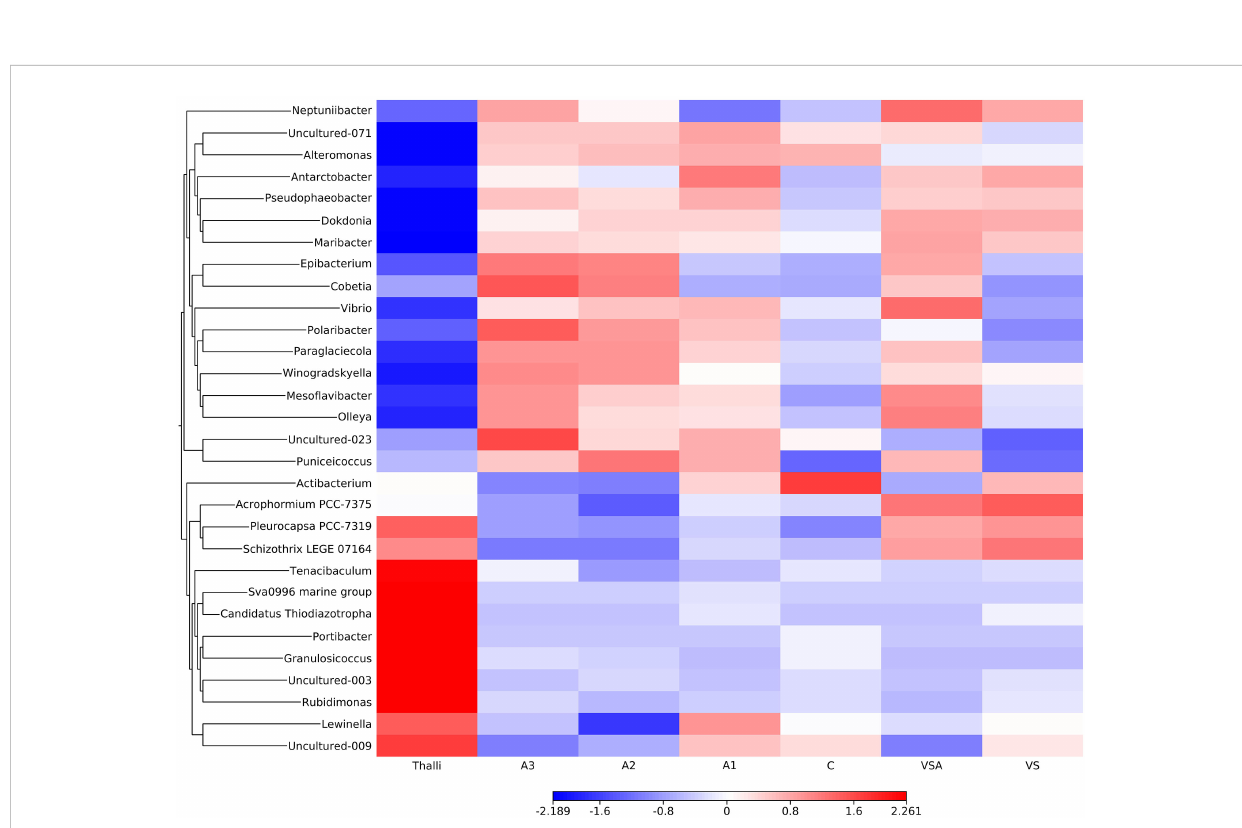
FIGURE 9 OTU relative abundance (20 most abundant families) aggregated per treatment over time of seedlings microbial bio fi lm. Bar height is proportional to taxa abundance.